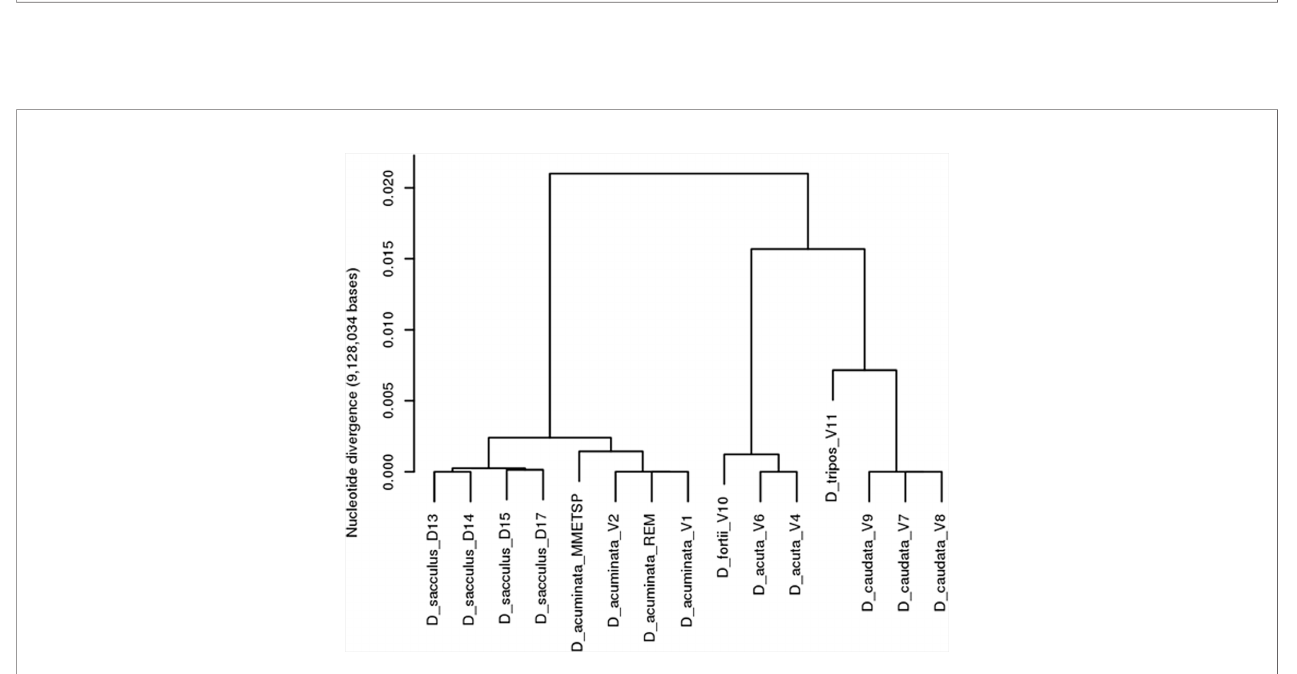
FIGURE 6 | Clustering of Dinophysis spp. strains based on genetic variation (296 887